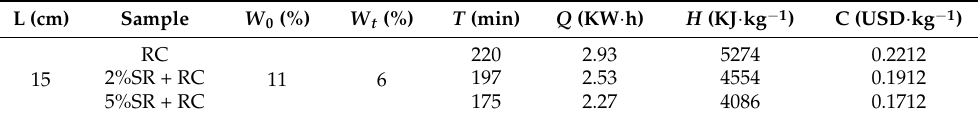
Table 4. Economic benefits